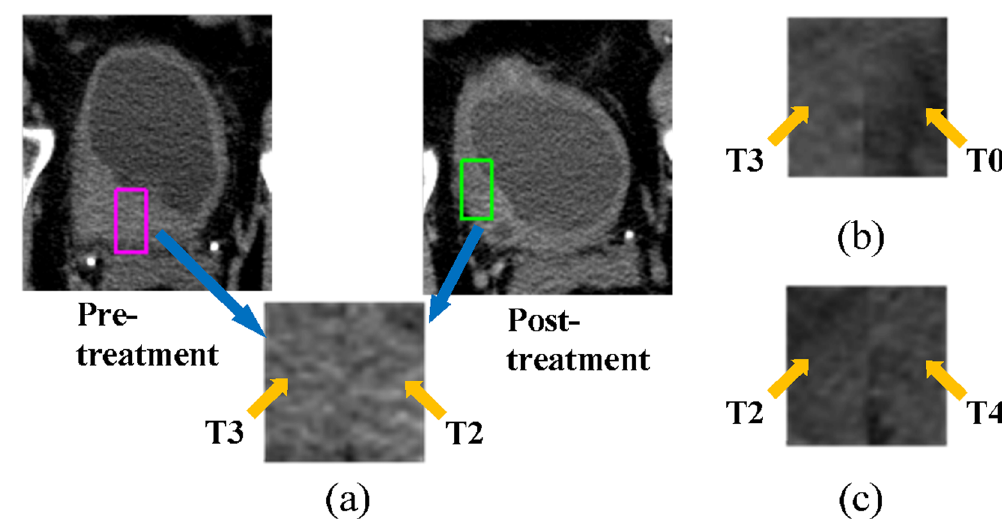
Figure 2. Creating ROIs to train the DL-CNN. ( a ) ROIs were generated by combining regions from the pre- and post-treatment scan lesions. In this example, the pre-treatment stage was T3, and the post-treatment stage was T2. Therefore, the ROI was labeled as being greater than stage T0 after treatment. ( b ) ROI of a case that was stage T3 pre-treatment and stage T0 after treatment. ( c ) ROI of a case that was stage T2 pre-treatment and stage T4 post-treatment. Therefore the ROI was labeled as greater than stage T0 after